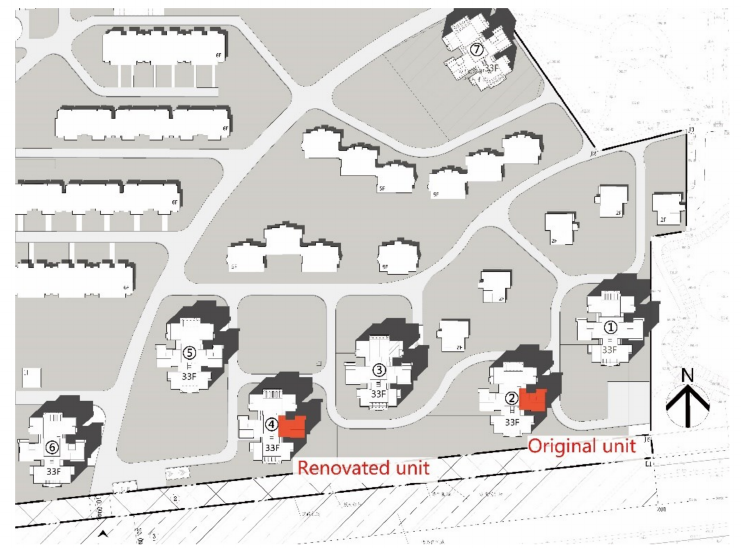
Figure 3. Site plan of the selected buildings.